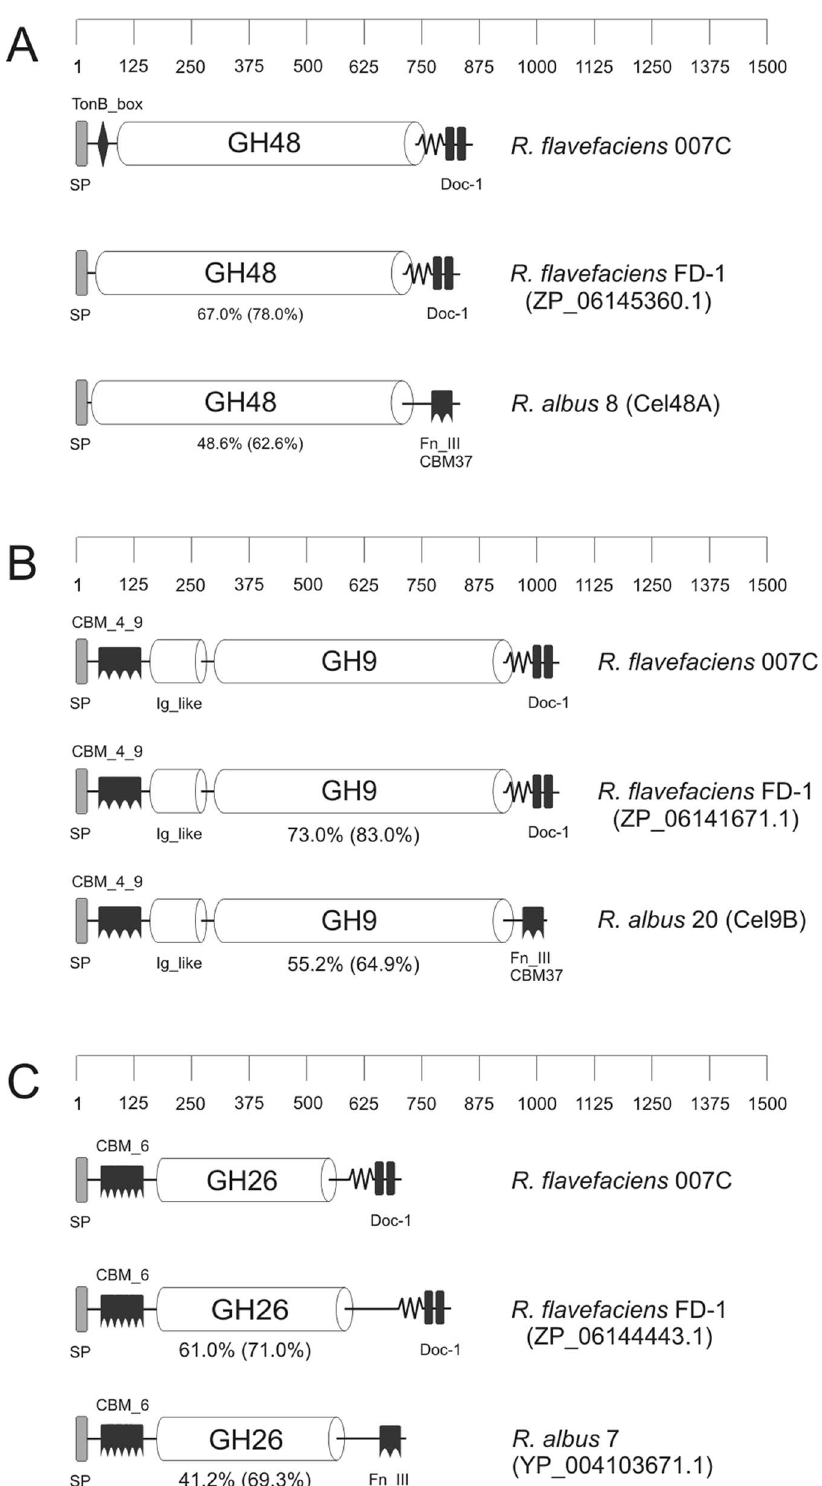
Figure 2. Modular structures of prominent glycoside hydrolases. These are compared with the predicted enzymes showing the highest % similarity (Blast) from R. flavefaciens FD-1 or R. albus : (A) glycoside hydrolase family 48; (B) glycoside hydrolase family 9; (C) glycoside hydrolase family 26. Abbreviations: SP - signal peptide, Doc-1 - dockerin type I, GH - glycoside hydrolase, CBM – carbohydrate-binding module, TonB_box: TonB- dependent receptor protein signature 1, Fn_III – fibronectin type III domain, Ig-like – immunoglobulin-like domain. The numbers below the R. flavefaciens FD-1 and R. albus enzymes represent % amino acid identity to the R. flavefaciens 007C homologue.